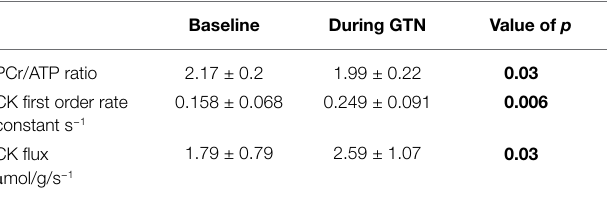
TABLE 4 | 31 P magnetic resonance spectroscopy measurements of myocardial energetics at rest and during GTN infusion. Baseline During GTN Value of p PCr/ATP ratio 2.17 ± 0.2 1.99 ± 0.22